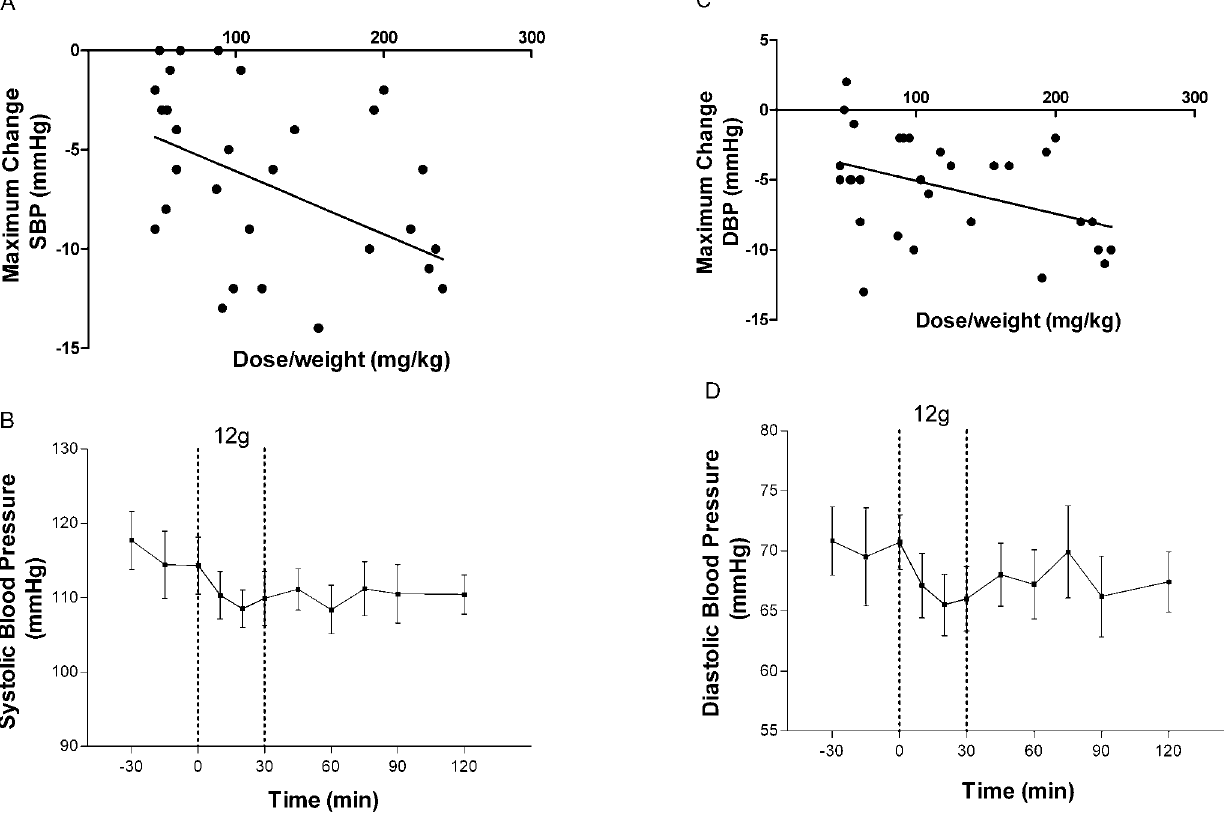
Figure 1. Effects of L-arginine hydrochloride infusion on blood pressure. Figure 1A: Relationship between dose/weight (mg/kg) of infused L-arginine and the maximal fall in systolic blood pressure at any time during or in the two hours following infusion (n=30; r = 2 0.463, p=0.015). Figure 1B: The systolic blood pressure profiles of patients before, during and up to 120 minutes after 30 minute administration of the highest dose of L-arginine (12 g; n=10). Shaded area indicates time of L-arginine infusion. Dots and bars indicate mean 6 SEM. Figure 1C: Relationship between dose/weight (mg/kg) of infused L-arginine and the maximal fall in diastolic blood pressure at any time during or in the two hours following infusion (n=30; r= 2 0.42, p=0.02). Figure 1D: The diastolic blood pressure profiles of patients before, during and up to 120 minutes after 30 minute administration of the highest dose of L-arginine (12 g; n=10). Shaded area indicates time of L-arginine infusion. Dots and bars indicate mean 6 SEM.